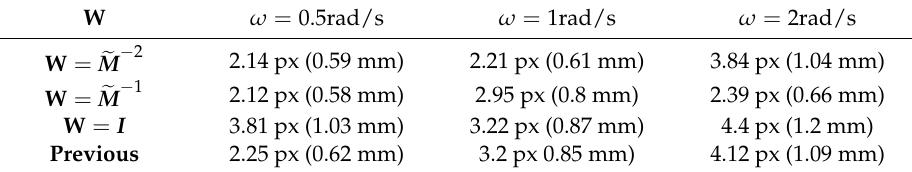
Table 1. Mean image error in pixels (mm) during the tracking of the image